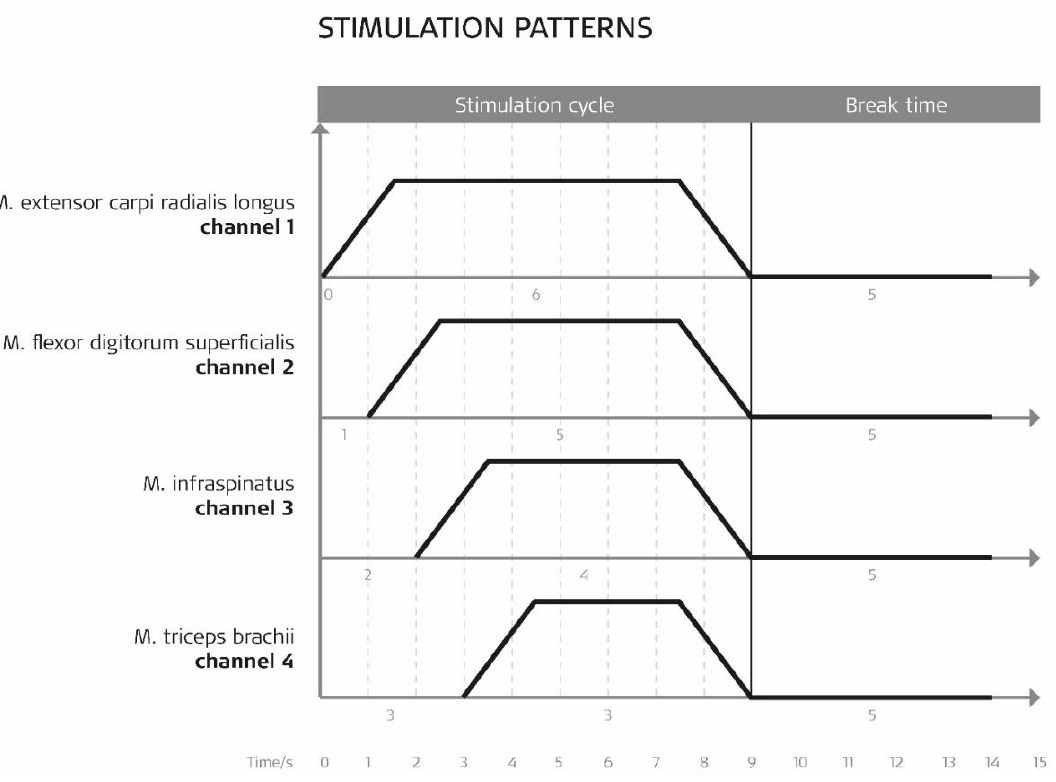
Figure 2. Stimulation pattern for EMG-MES with contraction and pause time, rise and fall time, and the stimulated muscles on the respective channels.